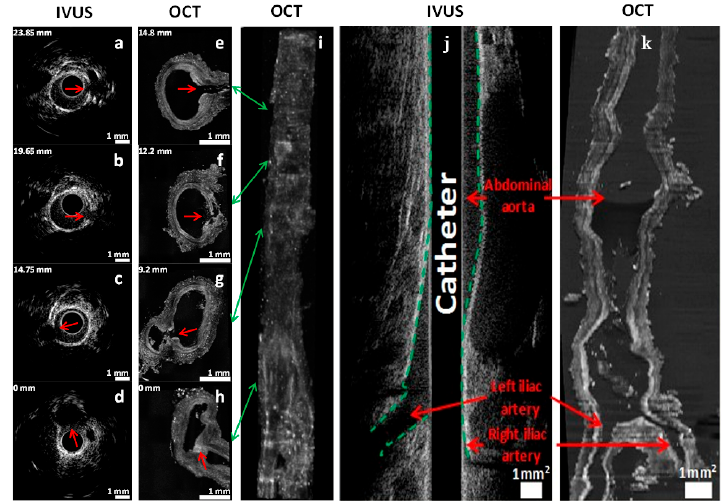
Figure 6. Intravascular ultrasound (IVUS) and OCT colocalization of anatomical landmarks in model 2. ( a – d ) In vivo IVUS cross-sectional images; ( e – h ) Ex vivo OCT cross-sectional images; ( i ) 3D reconstruction in OCT using a maximum intensity projection algorithm. Indicated numbers in mm (upper left of each image) represent the distances between the cross-section and the iliac bifurcation. The catheter was introduced in the right iliac artery, located at the bottom-right in the OCT image in ( h , i ). Green arrows indicate the location of the cross-section slices on 3D reconstruction. Red arrows denote side branches (anatomical landmarks) used for colocalization. Longitudinal view of the abdominal aorta and iliac arteries in IVUS and OCT imaging in model 2; ( j ) In vivo IVUS image of a 50 mm artery segment (green dashed lines delineates the arterial wall); ( k ) Ex vivo OCT image of the same segment, which shrunk to a length of 30 mm after ex vivo tissue fixation. Scale bars represent a region of 1 mm by 1 mm.